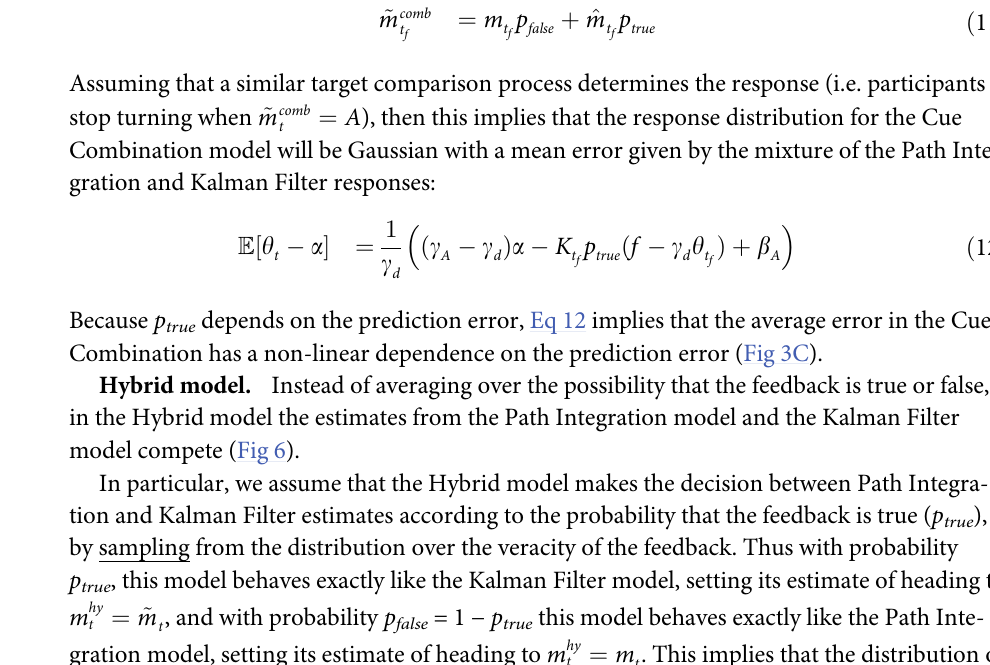
Fig 6. Schematic of the Hybrid model. The Hybrid model bases its estimate of heading, m hy Filter estimate. Here we illustrate the case where the model chooses the Kalman Filter estimate. The response is made when the hybrid estimate matches the remembered target